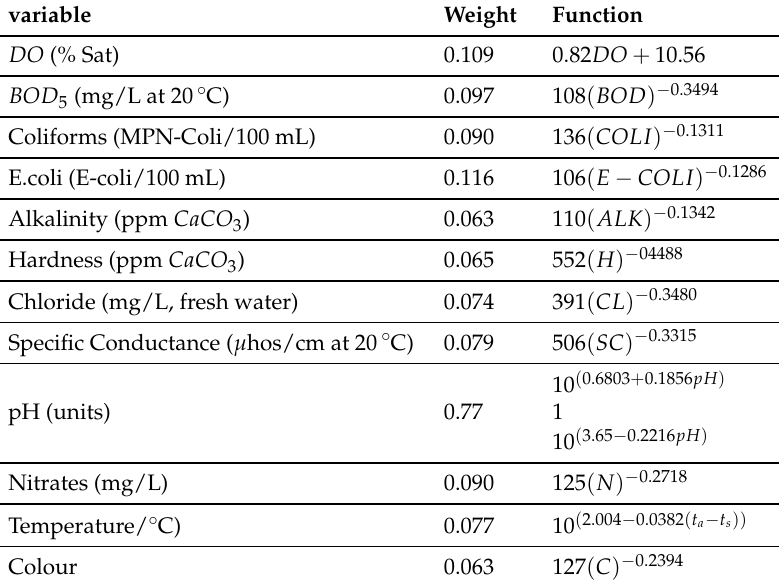
Table A6. Subindex Functions of the 1987 Dinius’